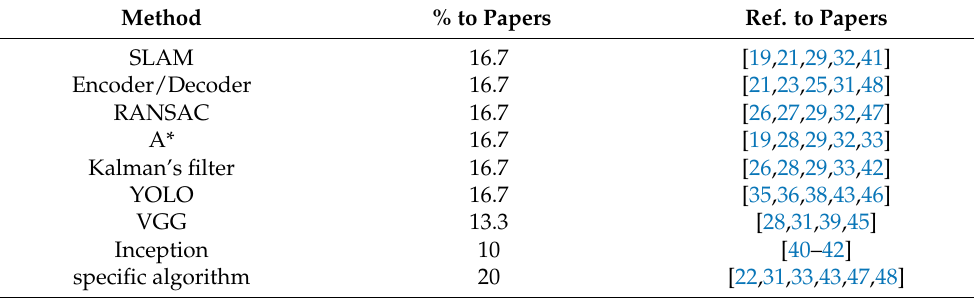
Table 8. most frequent methods.